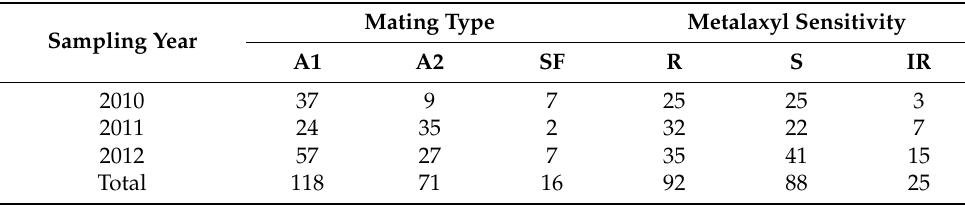
Figure 2. Mating-type frequencies of isolates of P. infestans across six Egyptian governorates ( A ) during the 3 years of the study ( B ). Table 2. Analysis of mating type, metalaxyl sensitivity, and clonal lineages of P. infestans isolates from six governorates of Egypt during three growing seasons.